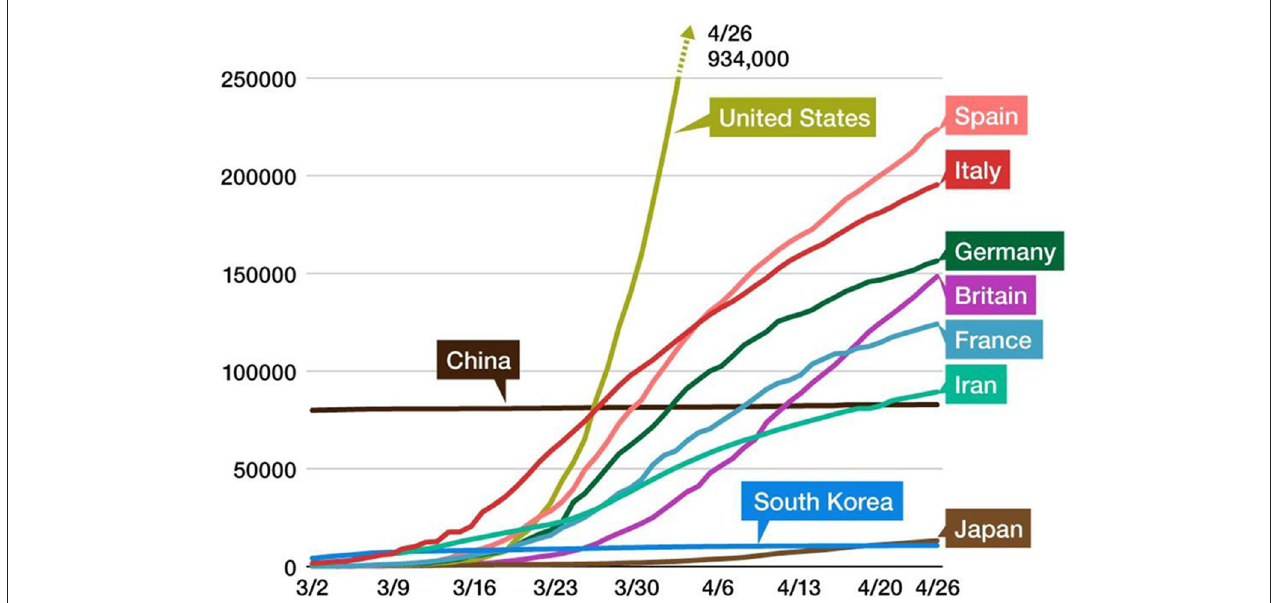
FIGURE 1 | Countries with the highest number of coronavirus disease 2019 (COVID-19) infections up to April 26th, 2020 (source: https://www.nippon.com/en/japan- data/h00673/).